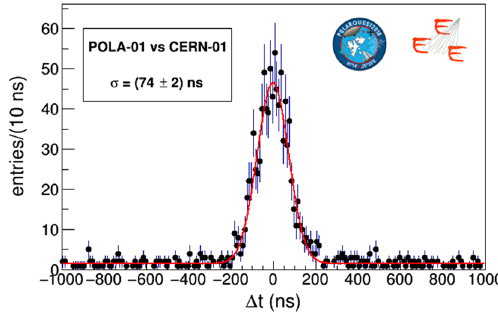
Fig. 8 TimecoincidencesbetweenPOLA-01andCERN-01;datawere taken on the June 17,